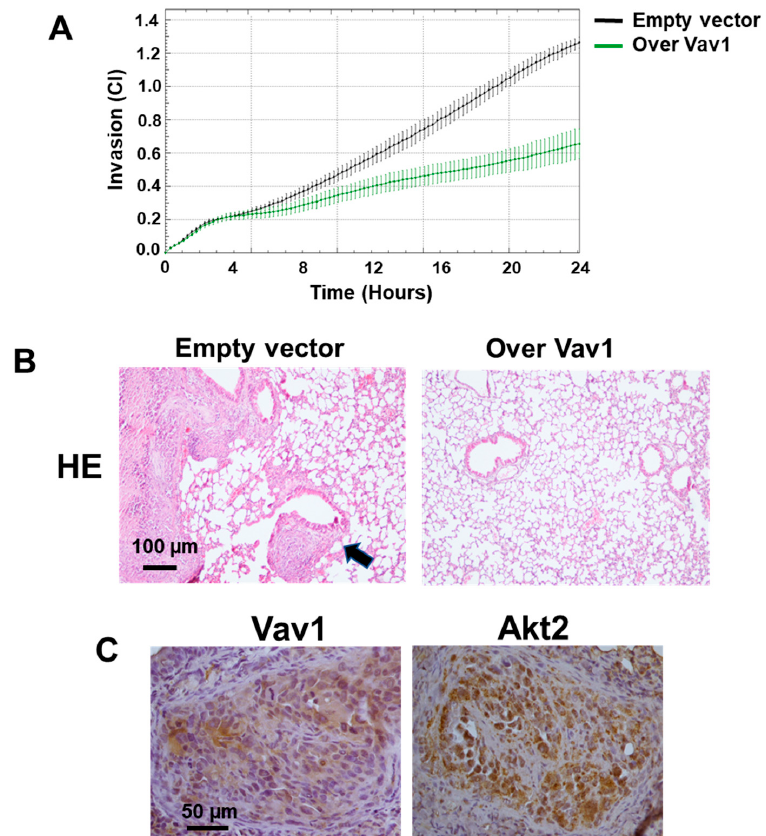
Figure 4. Effects of Vav1 on lung colonization of MDA-MB-231 cells. ( A ) Dynamic monitoring of invasiveness of MDA-MB-231 cells stably expressing an empty vector or Vav1. Cell Index (CI) values are reported, and error bars indicate SD. ( B ) Representative HE images of lung sections from mice following intravenous injection of MDA-MB-231 cells transfected with an empty vector or stably expressing Vav1. The arrow indicates a lung secondary tumor, whose immunohistochemical analysis of Vav1 and Akt2 was shown in ( C ).